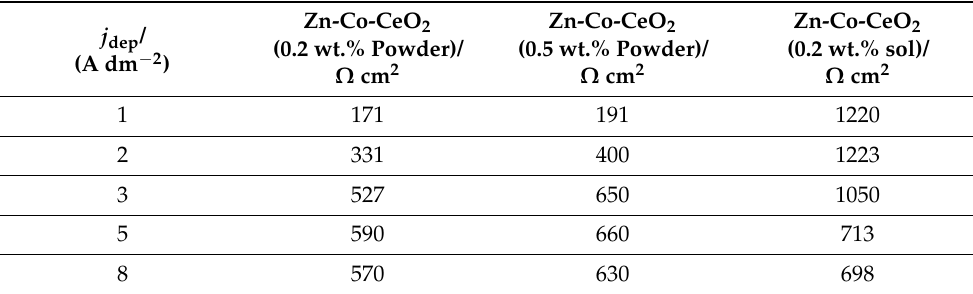
Figure 11. Morphology of the Zn-Co-CeO 2 composite coatings ultrasounddeposited at different current densities from the plating solution with 0.5 wt.% ceria powder. Table 2. Polarization resistance values of composite coatings deposited from the solutions